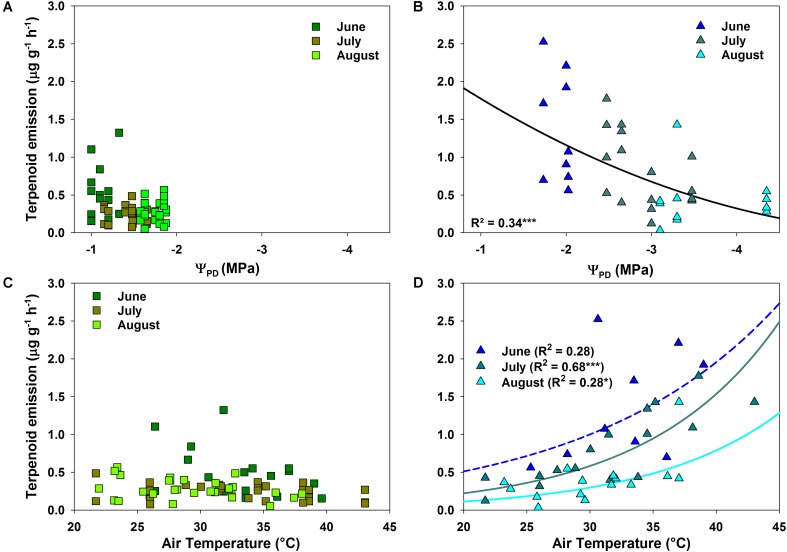
Response of measured terpenoid emission rates to pre-dawn leaf water potential (ΨPD) and air temperature for Q. suber
(A,C) and C. ladanifer
(B,D). Significant trends (linear and exponential regressions) are illustrated by solid lines at a significance levels of ∗p < 0.05, ∗∗p < 0.01, ∗∗∗p < 0.001.